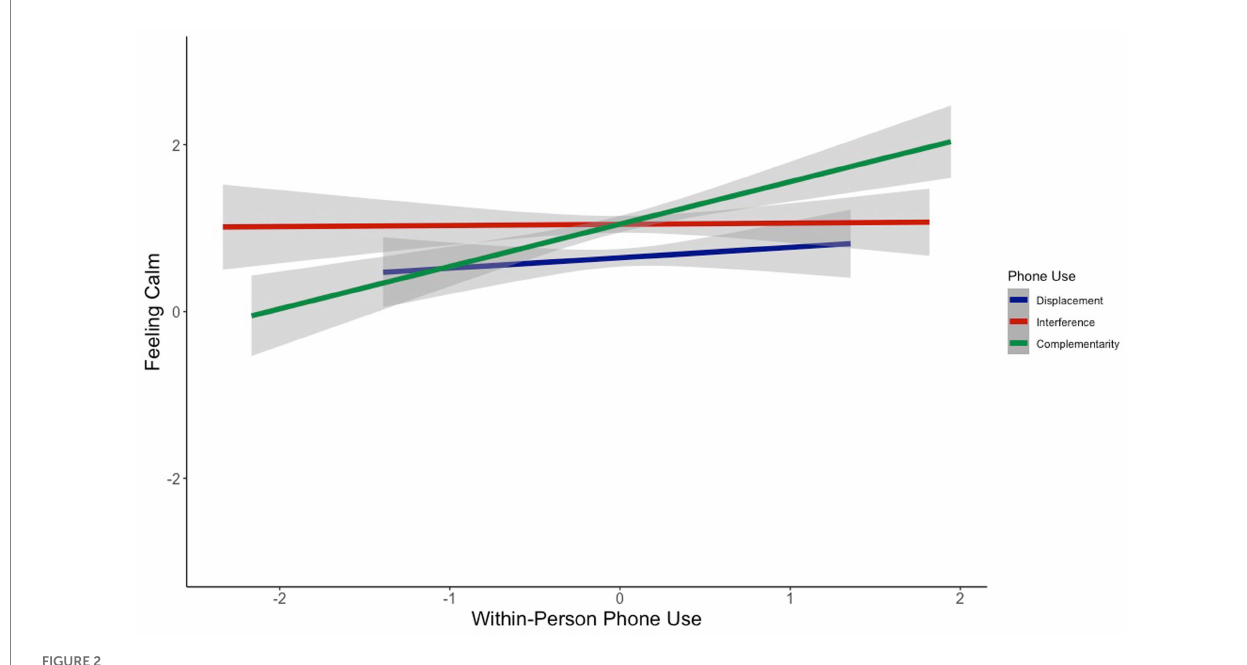
FIGURE 2 Association between within-person phone use and feeling calm.